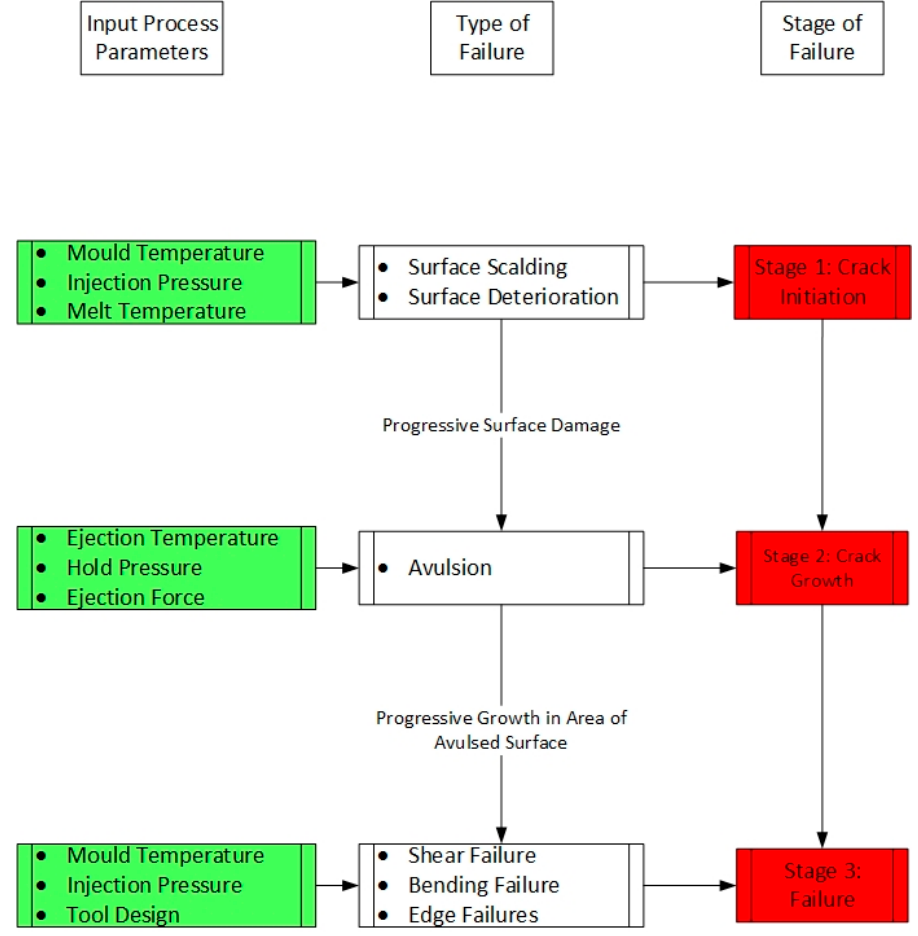
Figure 13. A conceptual map of the interaction between the root causes and the failure modes.